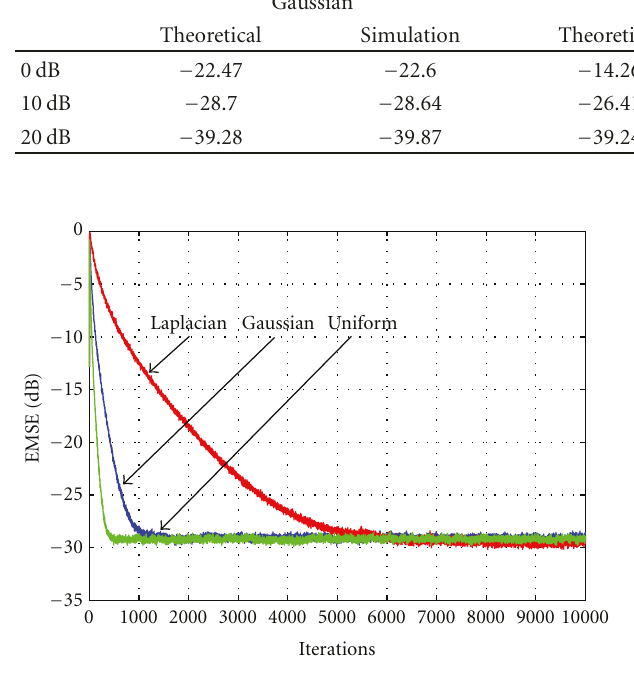
Figure 12: Learning behavior of the proposed algorithm in the di ff erent noise environments scenarios for p = 4 and α = 0 .